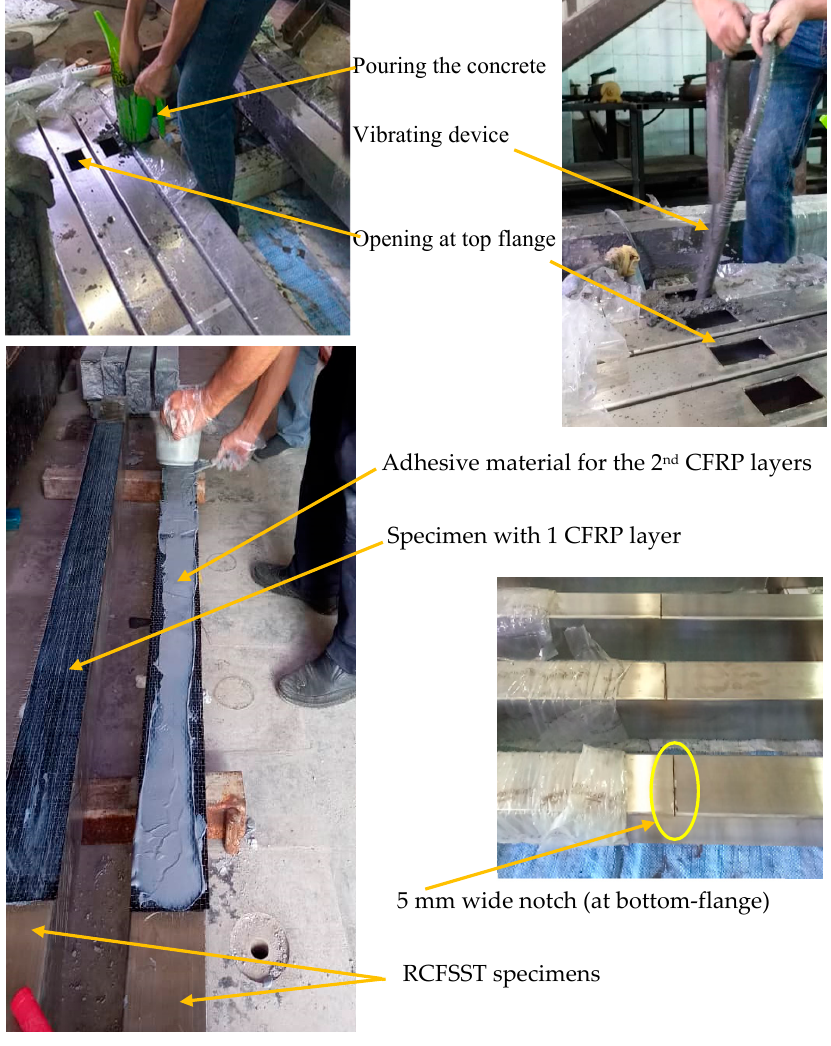
Figure 2. RCFSST specimen preparations. Table 2. Details of the tested RCFSST